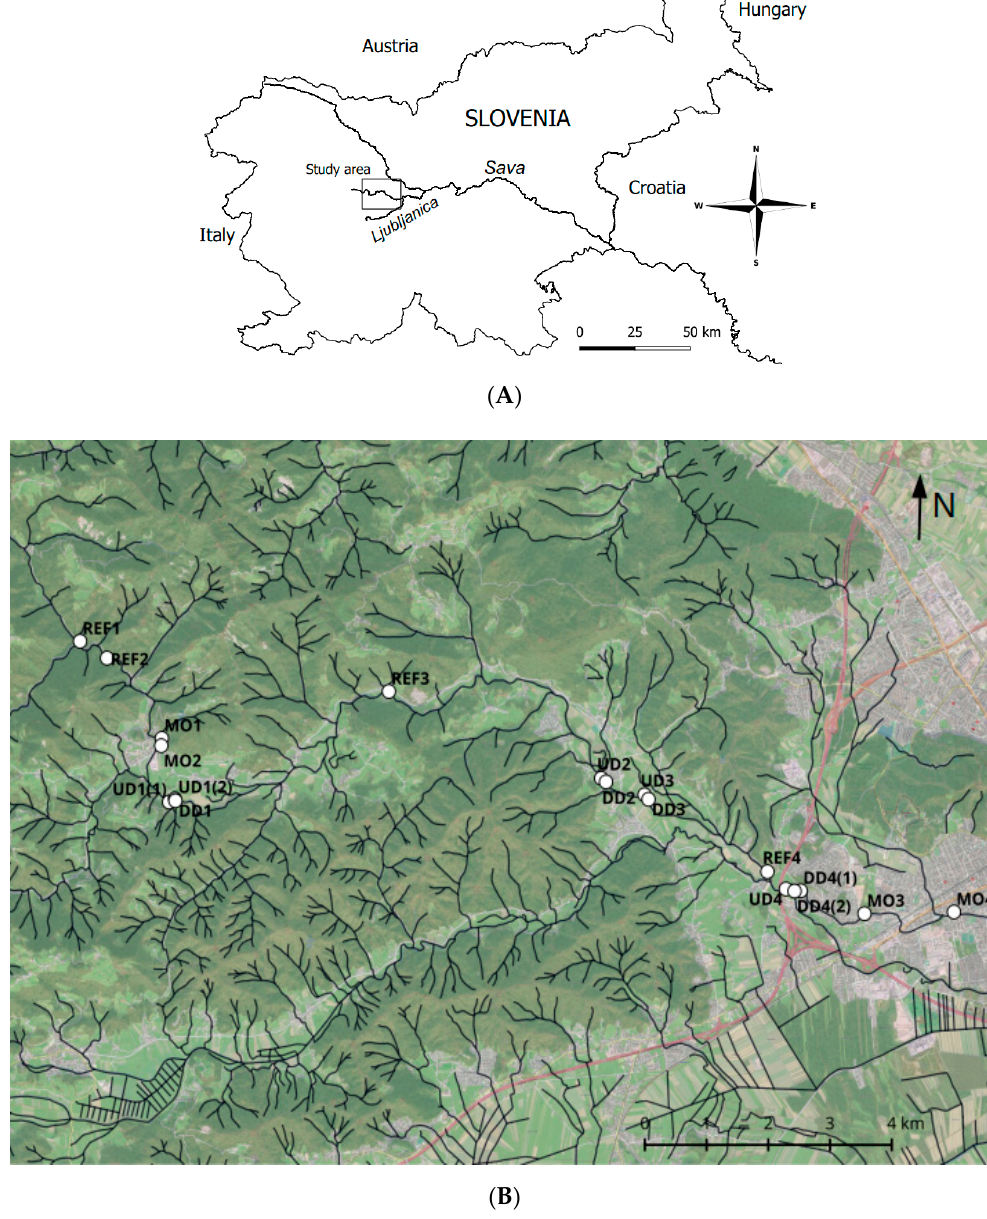
Figure 1. Map of the study area and sampling sites on the river Gradaš č ica: ( A ) study area within Slovenia; ( B ) locations of the sampling sites along the river Gradaš č ica. Reference sites without morphological alterations: REF1, REF2, REF3, REF4; most modified sites: MO1, MO2, MO3, MO4; sites upstream dams: UD1(1), UD1(2), UD2, UD3, UD4; sites downstream dams: DD1, DD2, DD3, DD4(1), DD4(2).